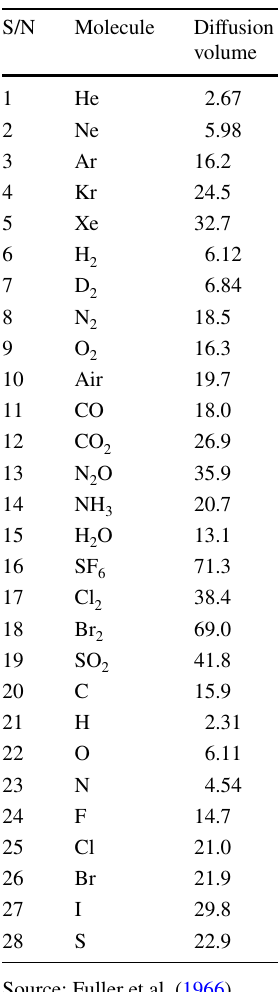
Table 1 Atomic diffusion contributions for various gas element and molecules